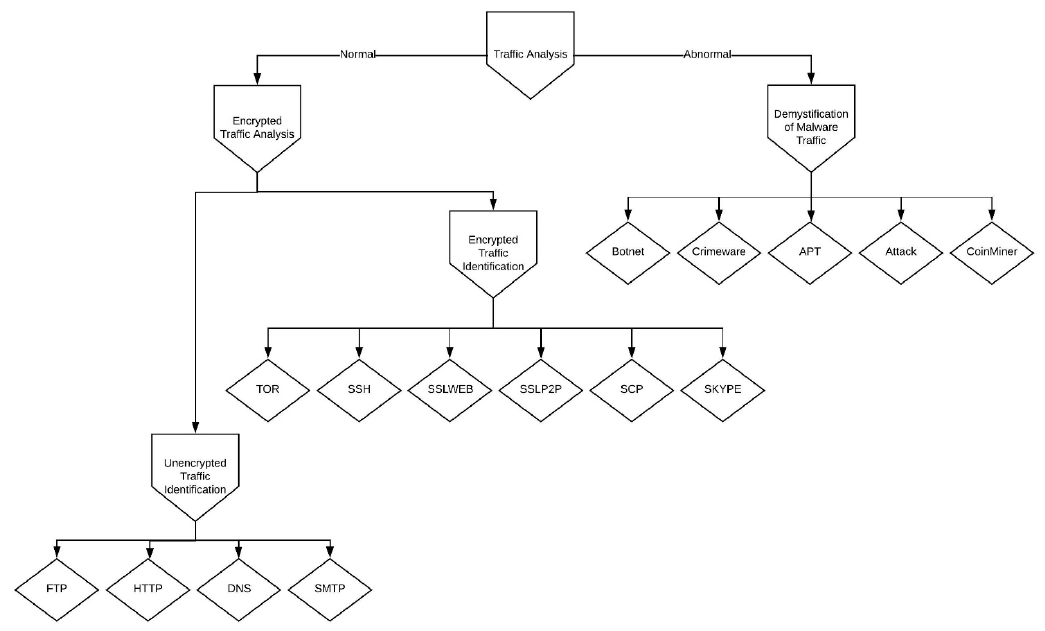
Figure 3. The classification process of the proposed λ -NF3.